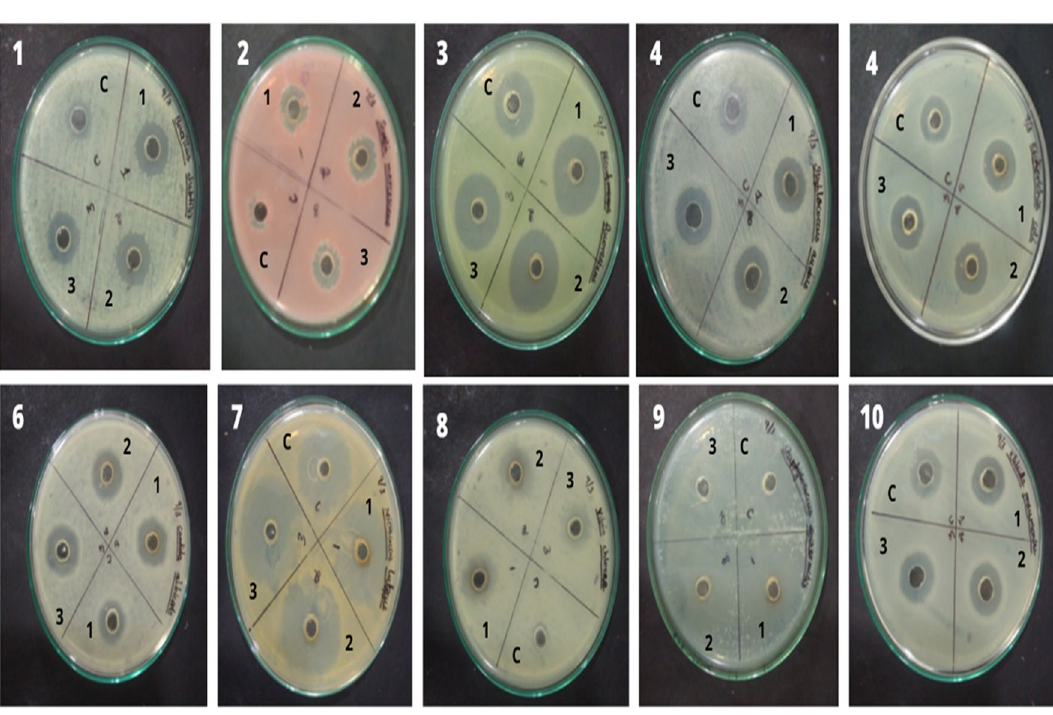
Figure 7. Antimicrobial activity of silver nanoparticles (1. Sargassum polycystum, 2 Acanthophora spicifera, and 3 Ulva fasciata ). 1. Bacillus subtilis, 2 . Serratia marcescens, 3 . Pseudomonas fluorescens, 4 . Staphylococcus aureus, 5 . Escherichia coli, 6 . Candida albicans, 7 . Micrococcus luteus, 8 . Vibrio cholerae, 9 . Staphylococcus epidermidis, 10. Klebsiella